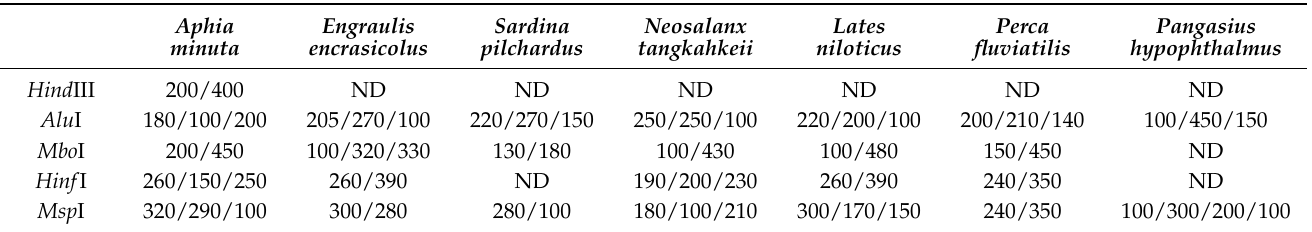
Table 2. COIBar-RFLP expected profiles (in base pair of DNA fragments) of the investigated species in this study. ND, not digested.